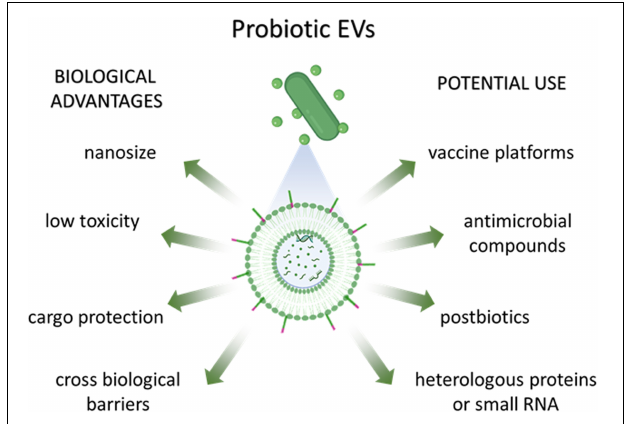
FIGURE 3 | Biological advantages and potential use of probiotic-derived